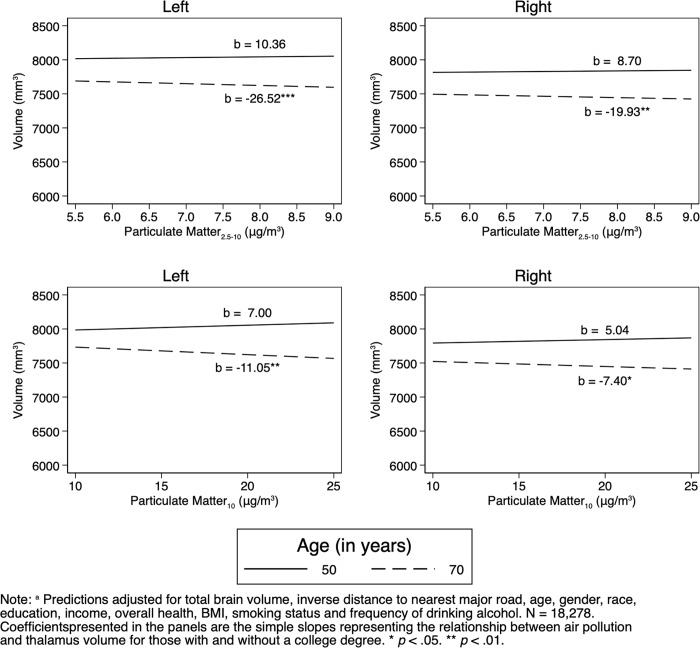
Interactions of pollution and age on thalamus volume: Adjusted predictionsa from OLS regressions.